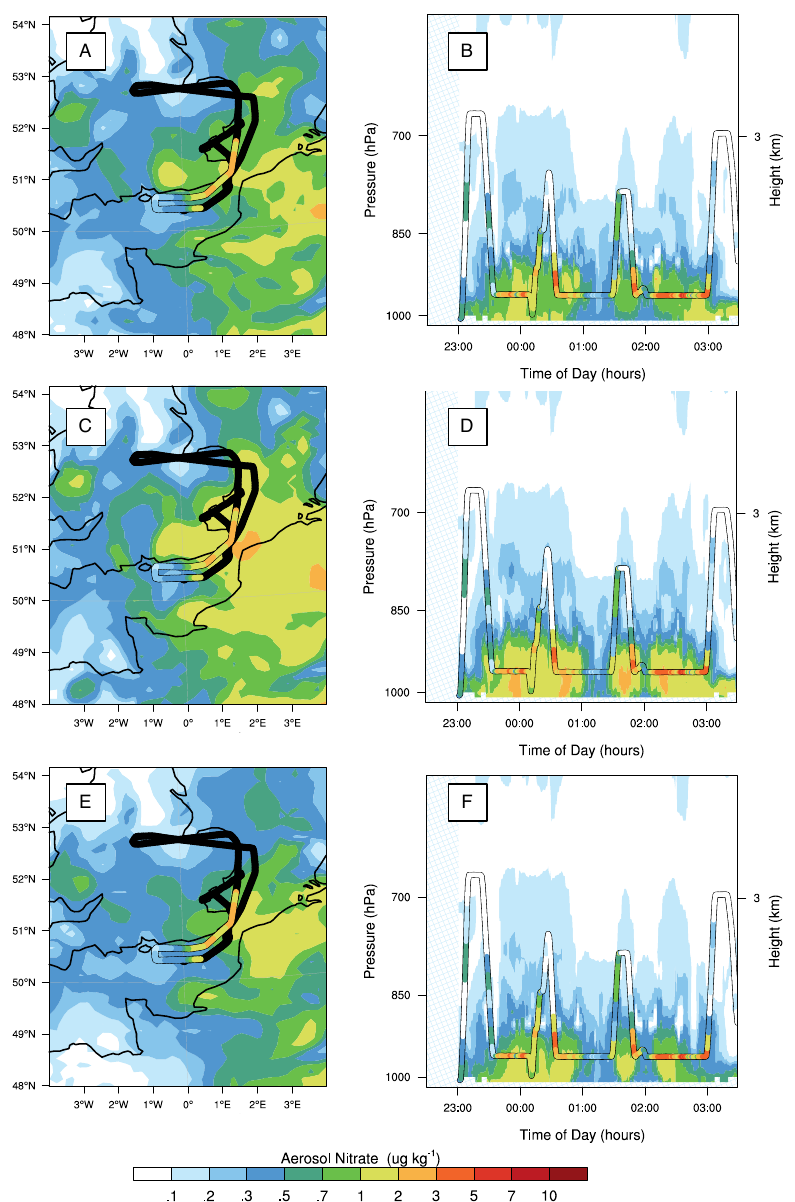
Figure 11. PM 1 nitrate mass loadings for the “het on” ( a and b ), “no Cl pathway” ( c and d ) and “het off” ( e and f ) for the B541 flight across the model domain. The aircraft flight track is indicated in all plots with a thick black line. Measurement data are superimposed upon that line using the same colour scale as the model data. ( a ), ( c ), and ( e ) are horizontal slices on the 960hPa pressure level at 01:00UTC (incorporating measurement data between 00:30 and 01:30UTC and 940 and 980hPa). ( b ), ( d ), and ( f ) are vertical curtain plots along the flight